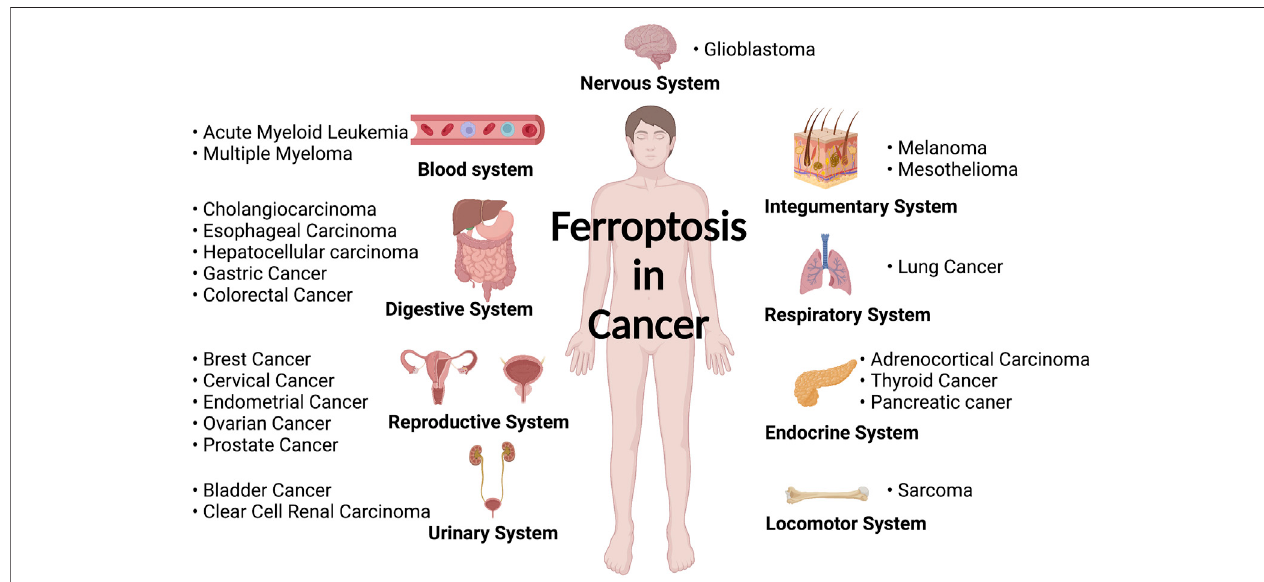
FIGURE 7 | Diseases related to ferroptosis in various human body systems (created with https://biorender.com/).